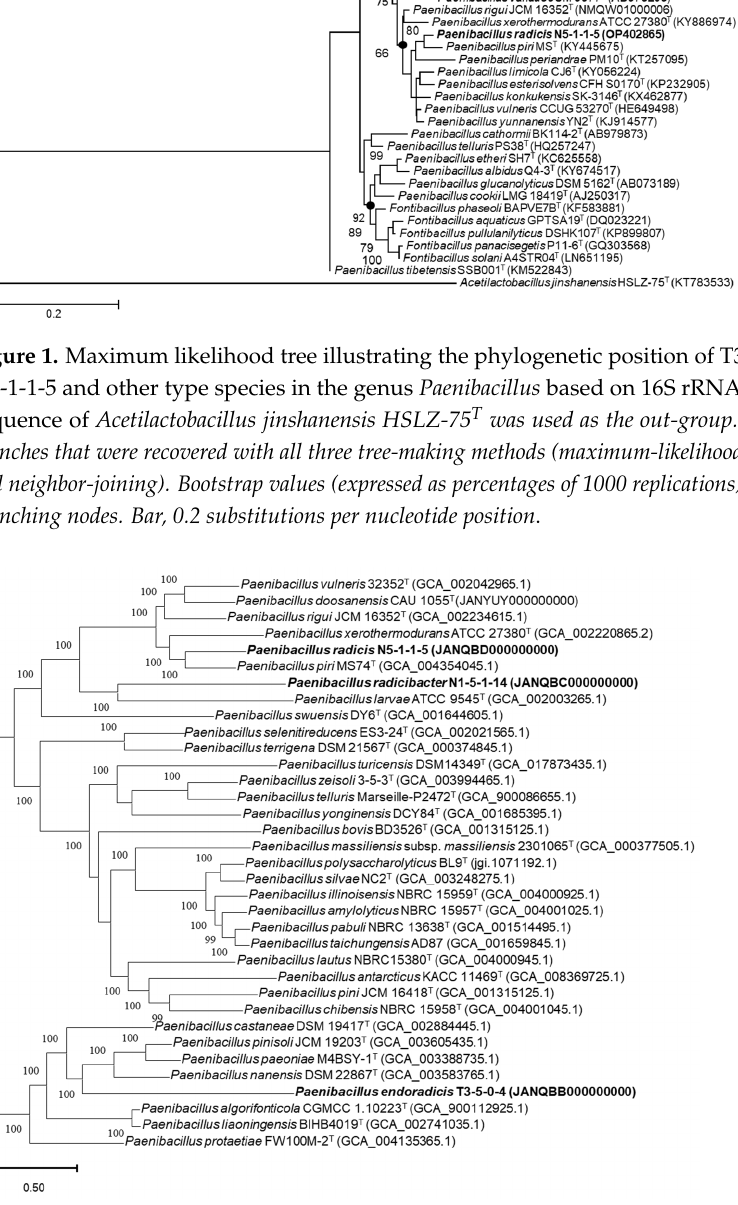
Figure 2. Phylogenetic tree based on whole genome comparison of of strains T3-5-0-4, N1-5-1-14, N5-1-1-5 and representatives of some related type strains in the genus Paenibacillus using RAxML within the codon tree pipeline at PATRIC, analyzing 258 single-copy coding sequences. Numbers at nodes represent confidence values of 100 rounds of fast bootstrapping. Bar, number of substitutions per site.